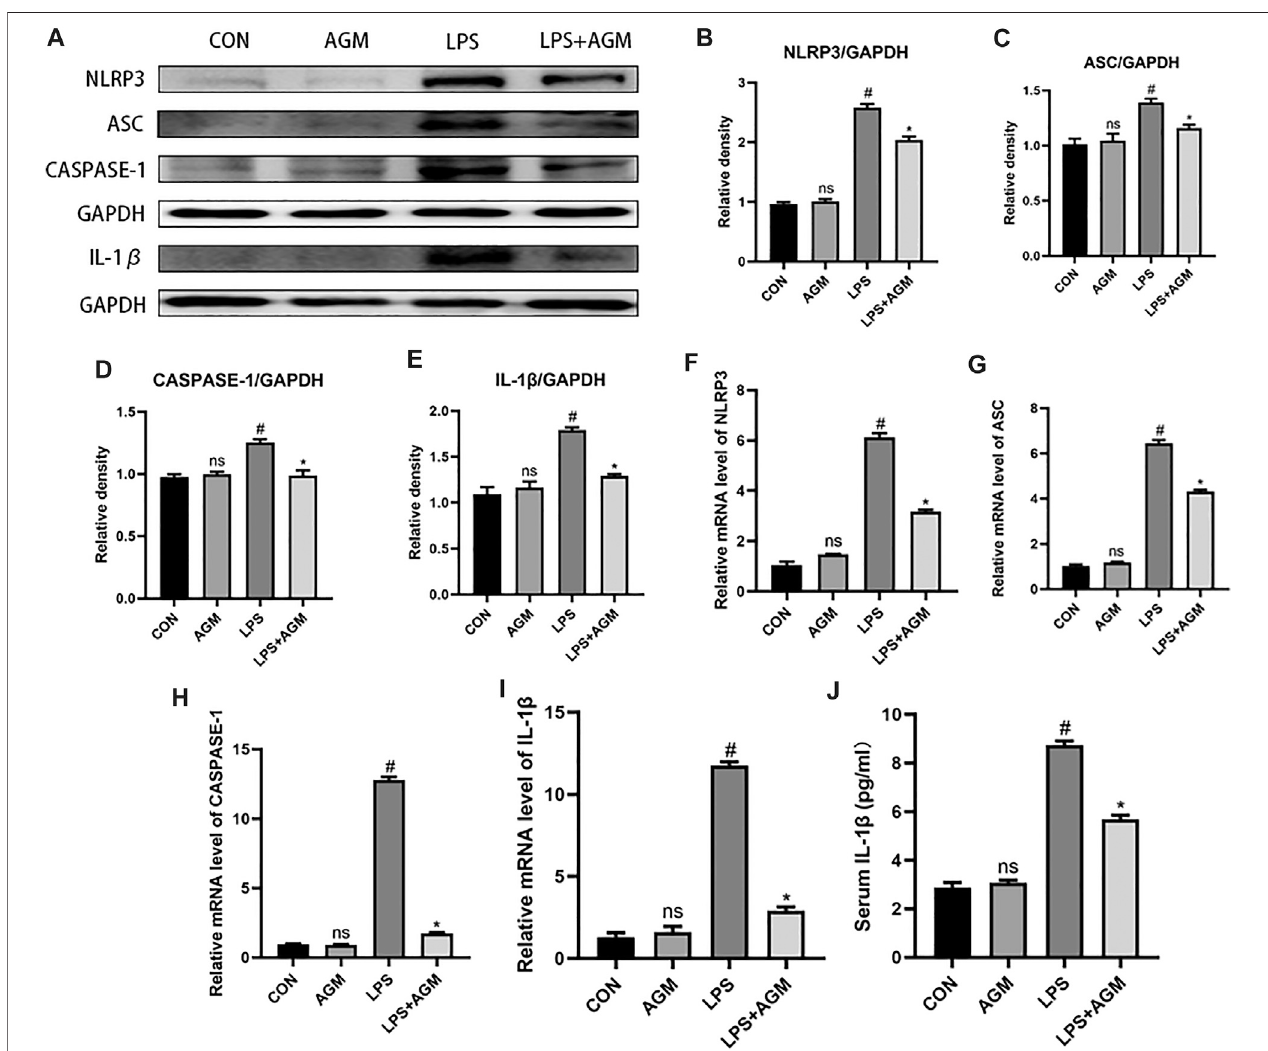
FIGURE 6 | Effects of AGM on in fl ammation-related proteins and mRNA in LPS-induced BV2 microglial cells. (A – E) Proteins expression level of in fl ammasome (NLRP3.ASC,CASPASE-1,IL-1 β )indifferentgroups(Student ’ stest). (F – I) mRNAexpression levelofin fl ammasome(NLRP3,ASC,CASPASE-1,IL-1 β )indifferentgroups (Student ’ s test). (J) The presence of IL-1 β was measured by ELISA (Student ’ s test). All data are shown as mean ± standard deviation.# p ＜ 0.05 vs the control and LPS group, * p ＜ 0.05 vs the LPS group and LPS + AGM group.